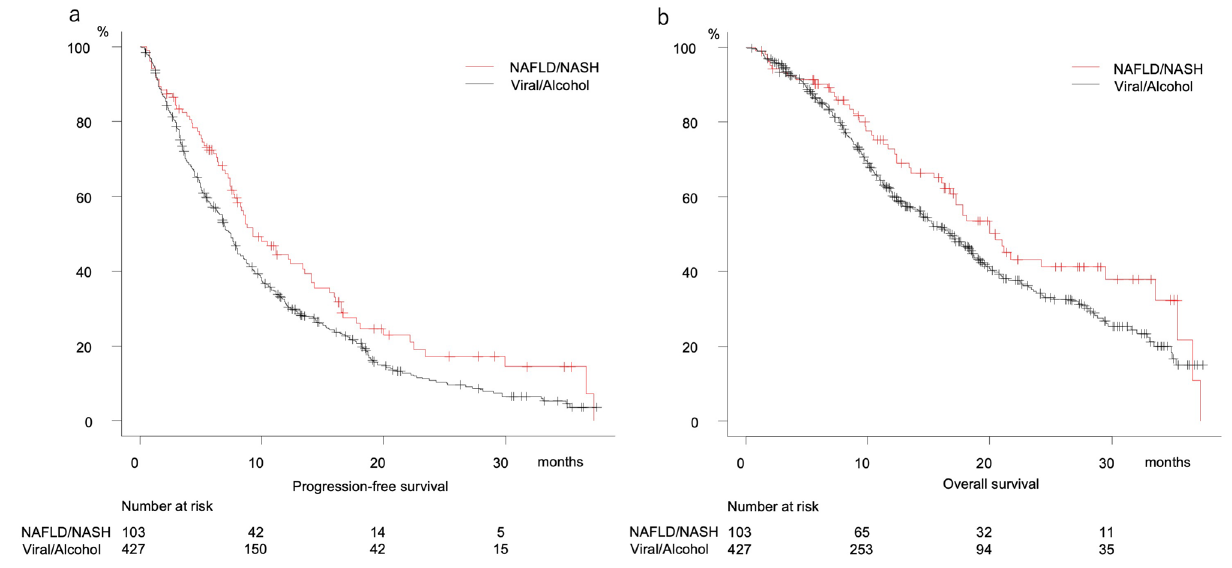
Figure 5. Progression-free and overall survival of NAFLD/NASH and Viral/Alcohol groups. ( a ) Progression- free survival. Viral/Alcohol (median 7.5 months, 95% CI 6.8–8.0), NAFLD/NASH (median 9.3 months, 95% CI 7.8–13.5) (P = 0.012). ( b ) Overall survival. Viral/Alcohol (median 16.9 months, 95% CI 14.5–18.6), NAFLD/ NASH (median 20.5 months, 95% CI 16.8–29.5). (P =